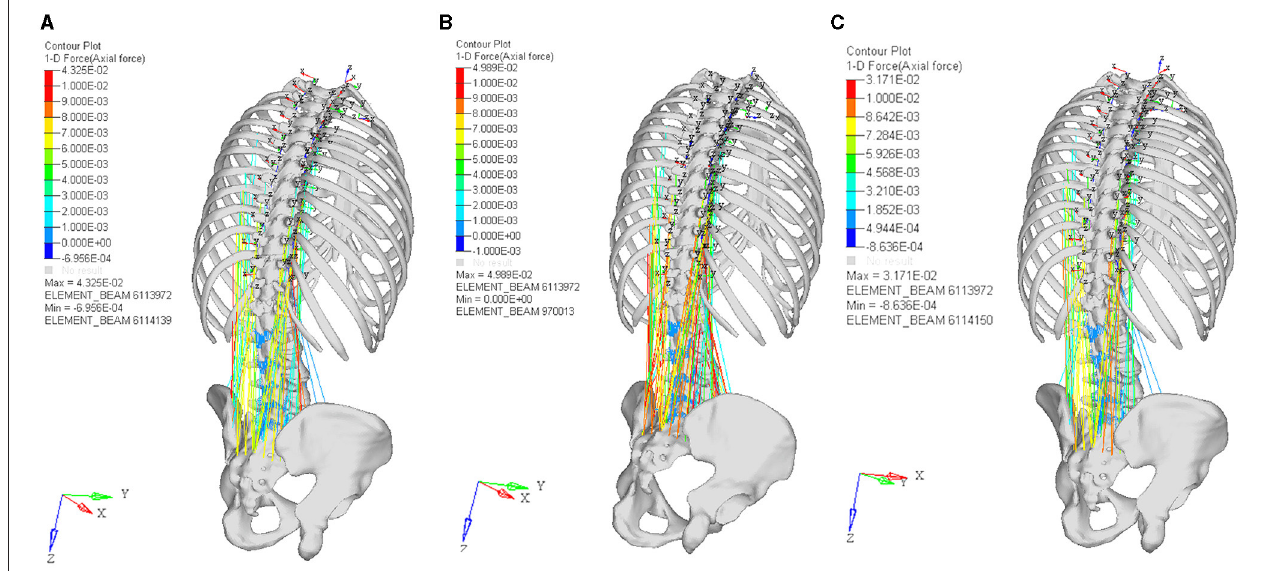
FIGURE 4 | The muscle force contribution of bending without lifting weight posture (A) , the bending with lifting 3-year-old child posture (B) , and upright with 3-year-old child posture (C) .